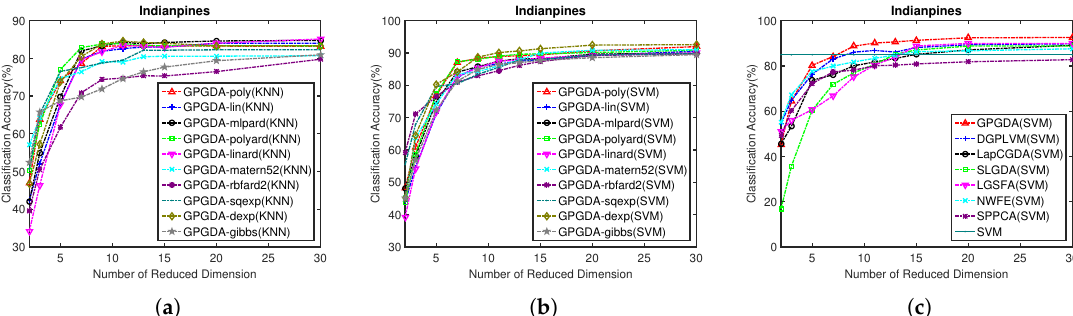
Figure 5. Classification accuracy w.r.t. different kernels and different dimensionality of the projection space on Indian Pines data: ( a ) KNN classification results of GPGDA based on different kernels; ( b ) SVM classification results of GPGDA based on different kernels, and ( c ) SVM classification results of all the DR methods based on different dimensions.